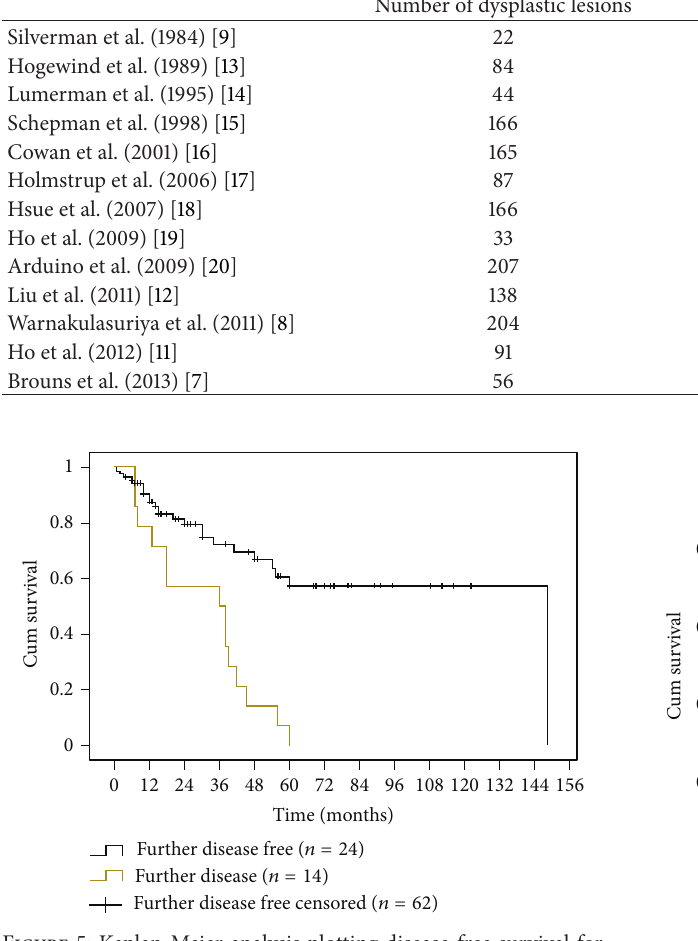
Figure 5: Kaplan-Meier analysis plotting disease-free survival for further (new site) disease and further disease-free patients ( 𝑃 = 0.0001 , Log-Rank test).